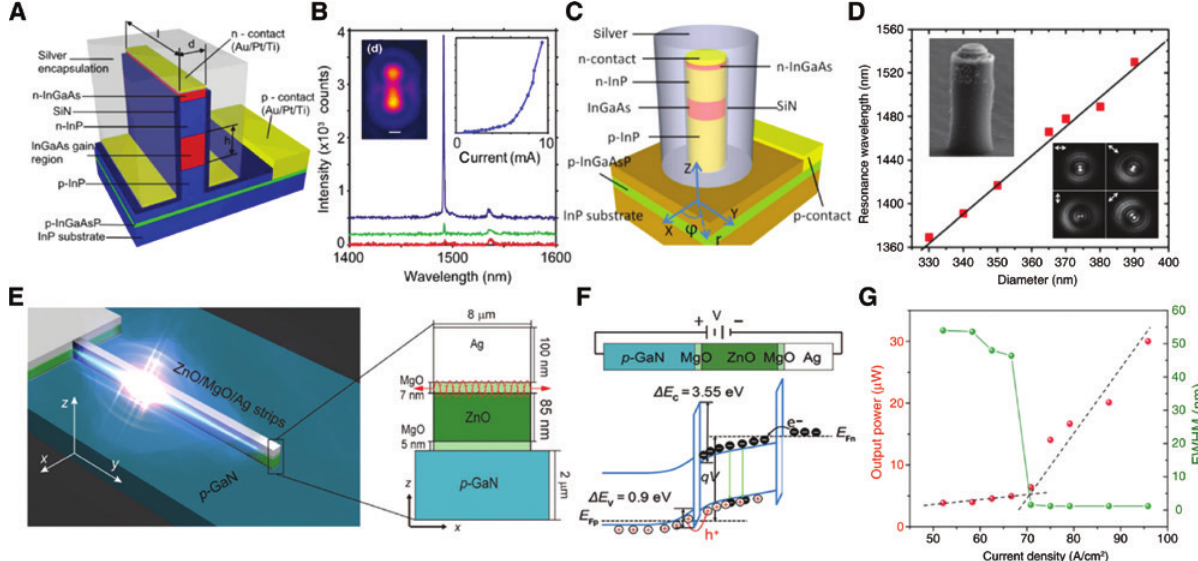
Figure 6: Electrically driven plasmonic NW